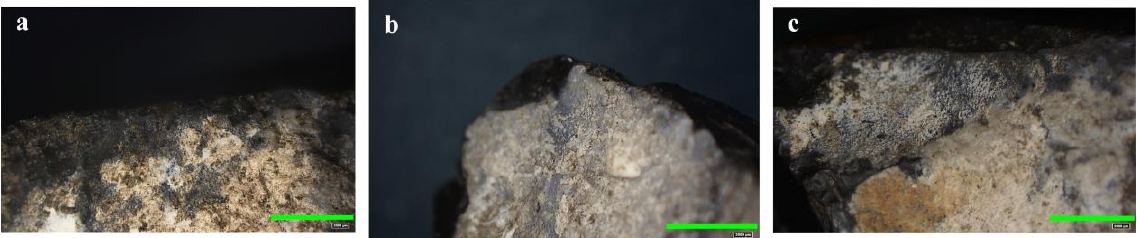
Figure 16. Chalky white patina and cortex on the retouched blade from Cluster 1, sample 21: a) lateral edge; b) distal dorsal end; c) proximal end close by lateral edge, scale bar equal to 2000 μm